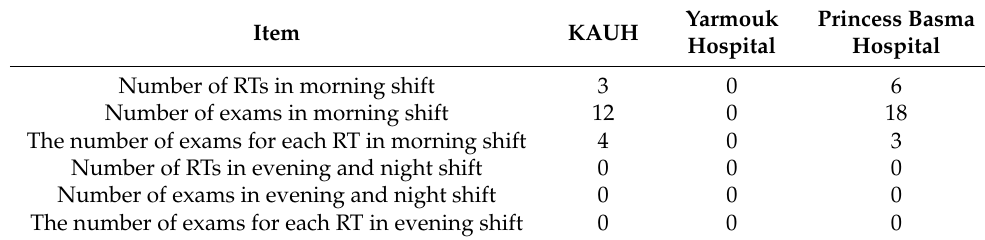
Yarmouk Princess Basma Hospital Hospital